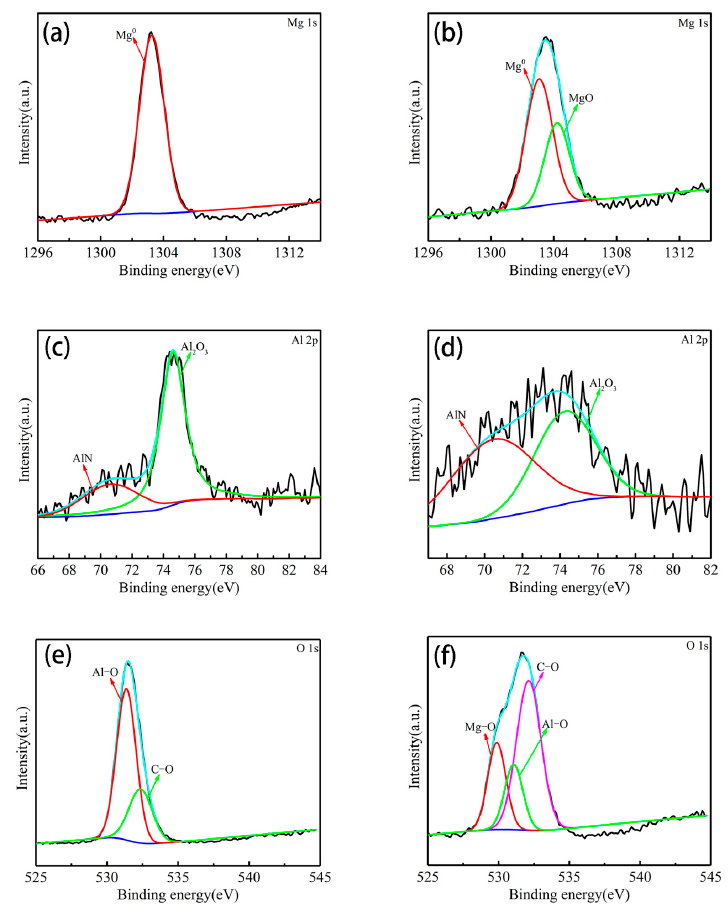
Figure 7. XPS high resolution spectrum of ( a ) Mg 1s, ( c ) Al 2p; ( e ) O 1s core level spectrum of MA, ( b ) Mg 1s and ( d ) Al 2p; ( f ) O 1s core level spectrum of SMA.